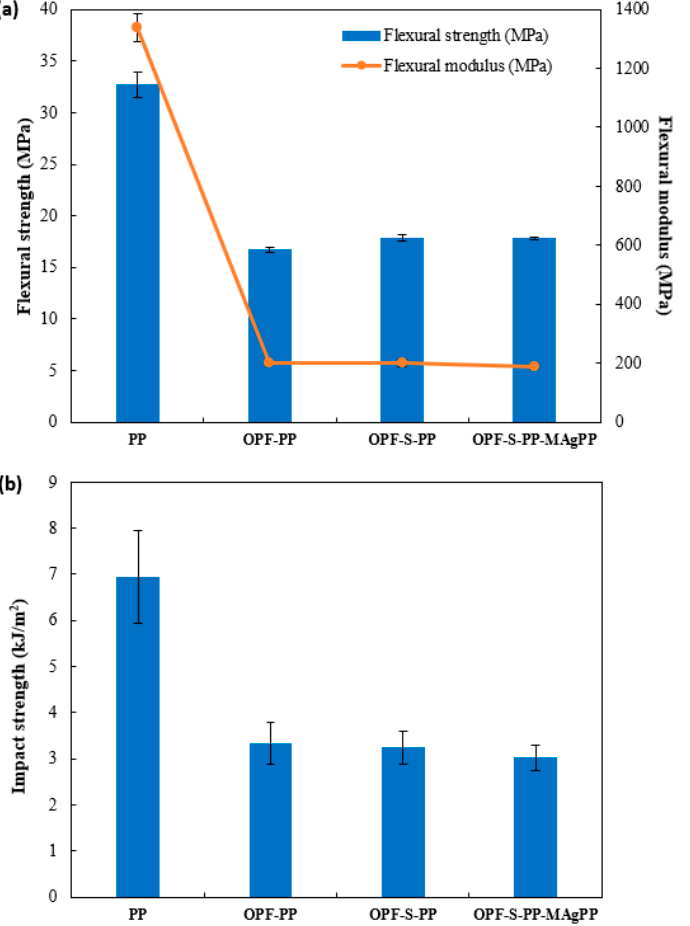
Figure 8. ( a ) Flexural properties and ( b ) impact strengths of PP, OPF-PP, OPF-S-PP, and OPF-S- MAgPP PP-MAgPP composites.